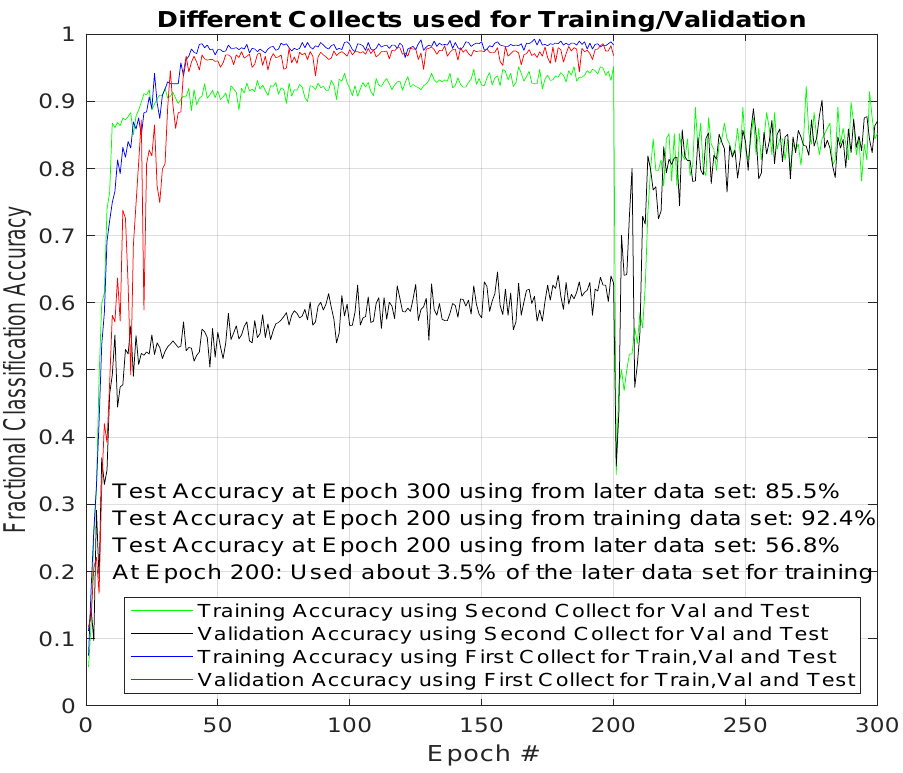
Figure 4. Stationarity experimentation using FFT with a 10 × noise augmentation and switching training set from the second collection to the first one at epoch